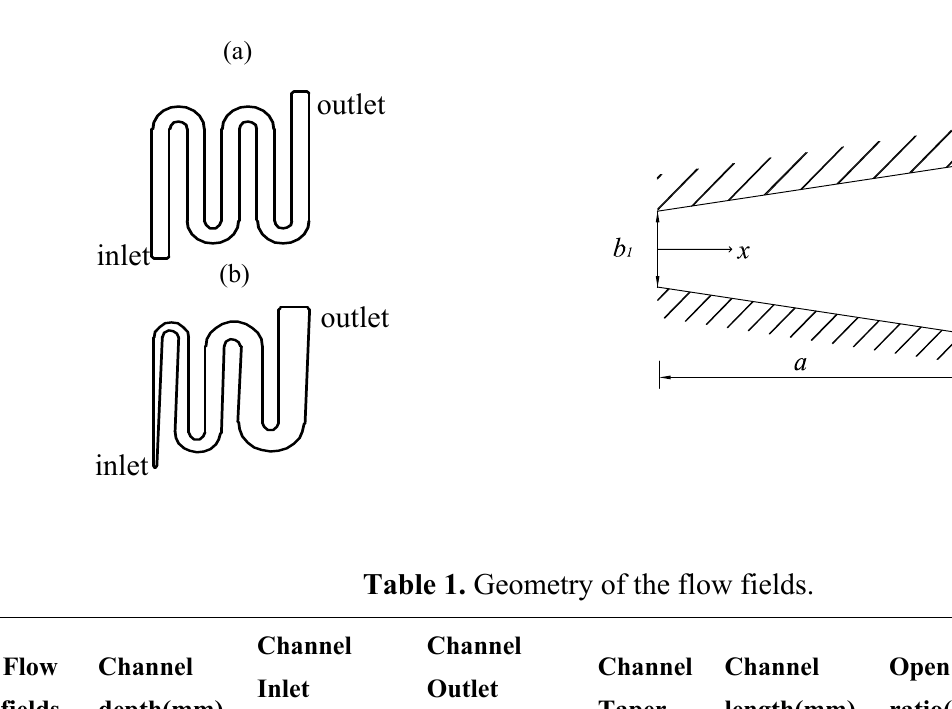
Figure 3. Geometric relations of NESFF channel.